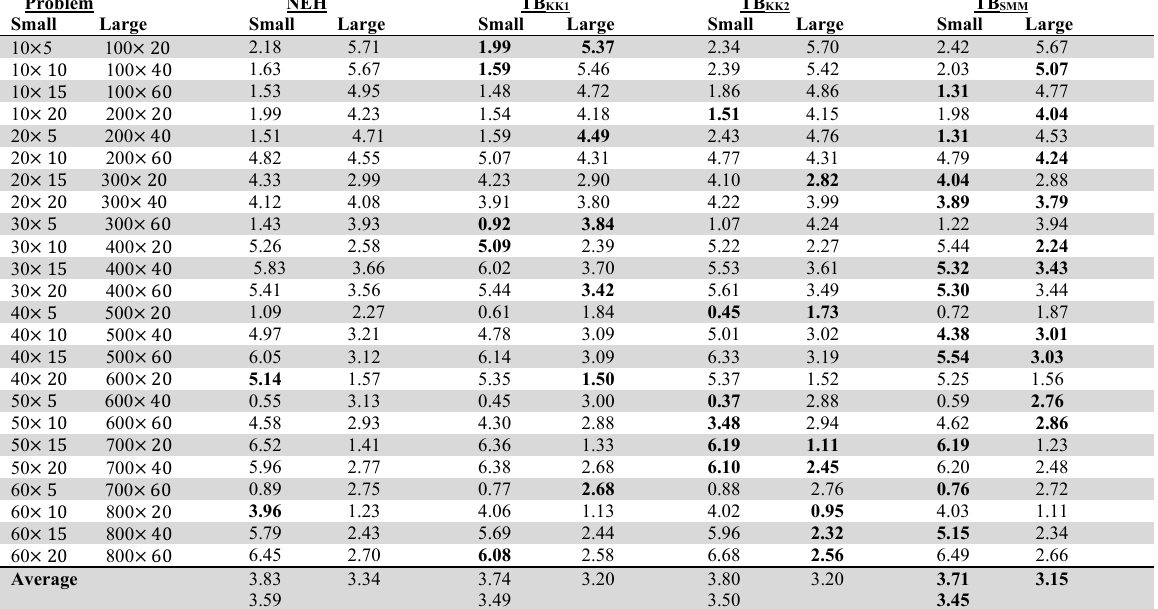
ARPD values of different heuristics on VRF instances Problem Small